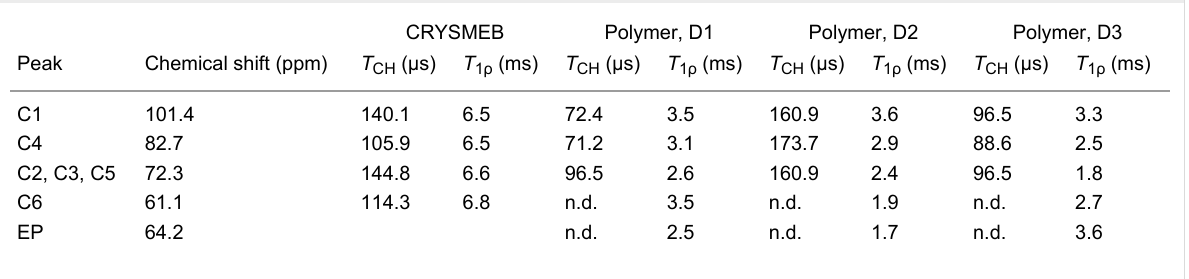
Table 2: 13 C Chemical shifts (ppm), T CH values (in μ s) and 1 H spin-lattice relaxation in the rotating frame ( T 1 ρ in ms) of the carbon atoms of CRYSMEB and the polymers D1, D2 and D3. CRYSMEB